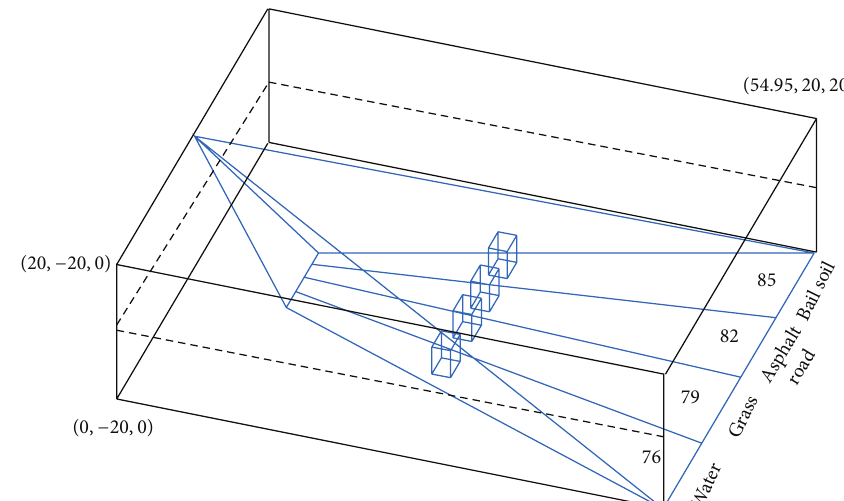
Figure 13: Virtual scene of rough surfaces of different roughness, in which the working frequency is assumed to be 94 GHz and the relative complex permittivity of the four surfaces is assumed to be (81.0, 1.0), (1.353, 0.070), (6.0, 0.1), and (2.1, 0.9), consequently, and the relative complex permittivity of the four rectangular bodies is assumed to be (3.50, 1.20) which is like the cement material. In the scene, the average brightness temperature of sky background, rectangles, and planes is assumed to be 50K, 300 K, and 200 K,